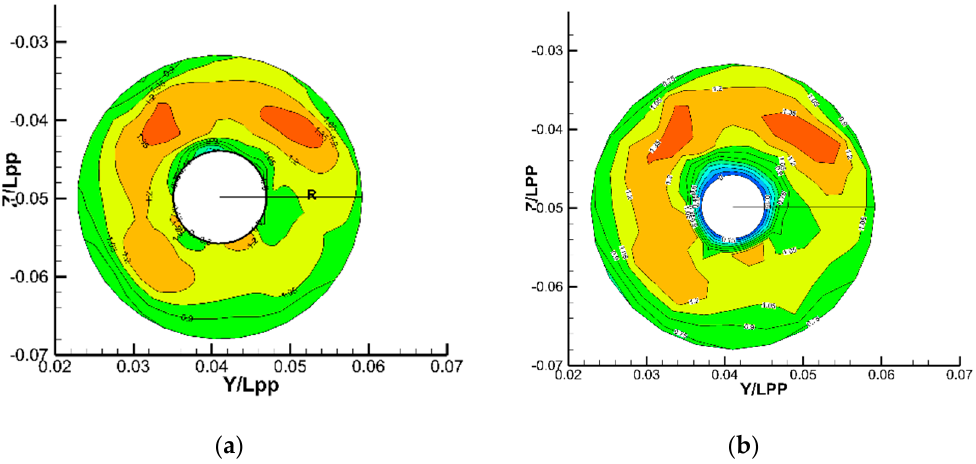
Figure 8. Axial flow field of the full scale and model scale at X / L pp = 0.103: ( a ) Full scale: Fn = 0.182, n = 1.555 rps; ( b ) Model scale: Fn = 0.182, n = 6.707 rps.